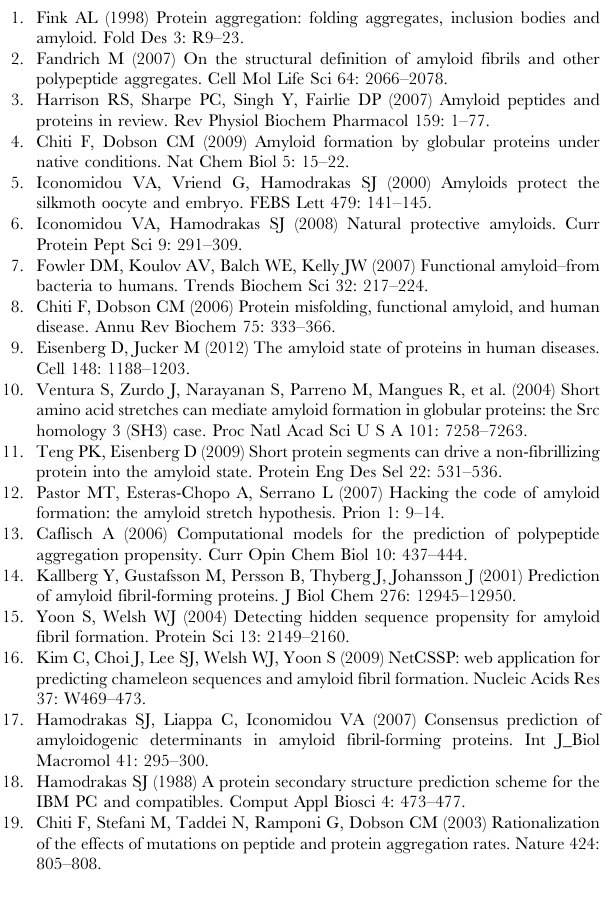
Table S2 MCC per protein per method. The main reason that the majority of methods has a low MCC with regard to